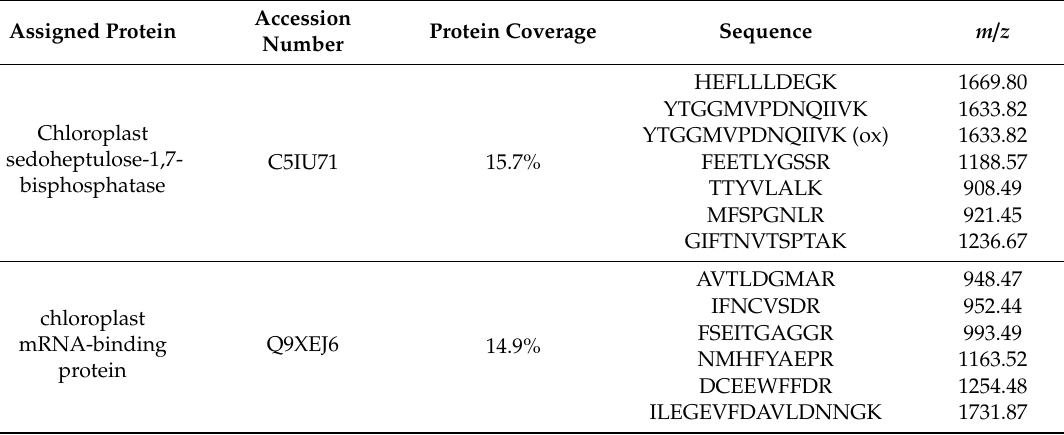
Table 1. Protein assignment of the band cut from the